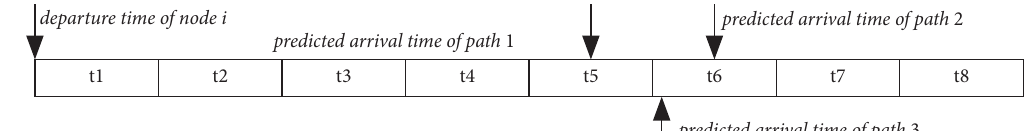
Figure 5: Schematic diagram of predicted arrival